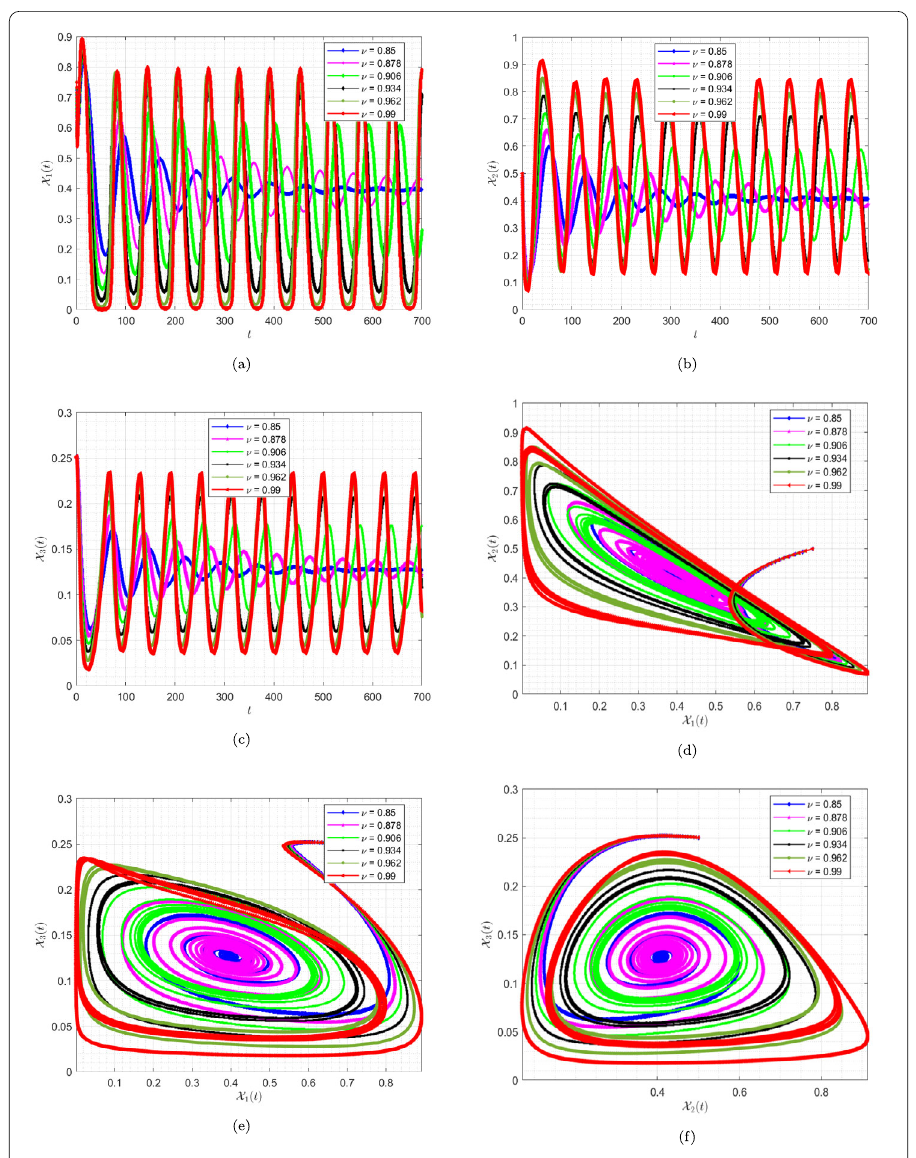
Figure 3 Dynamics for system (19) for different parameters in Set2